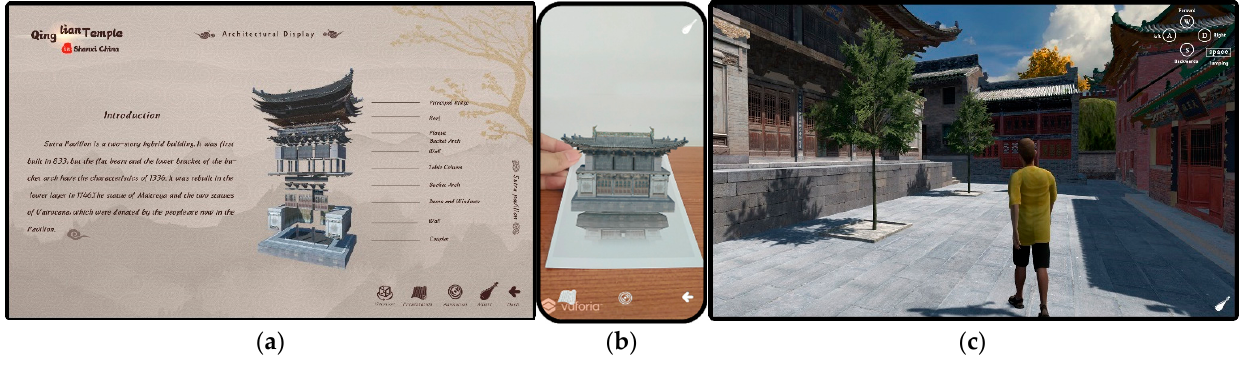
Figure 15. Cross-platform applications: ( a ) building disassembly animation using an Table PC, ( b ) AR using a Smartphone, and ( c ) automatic roaming using a PC.